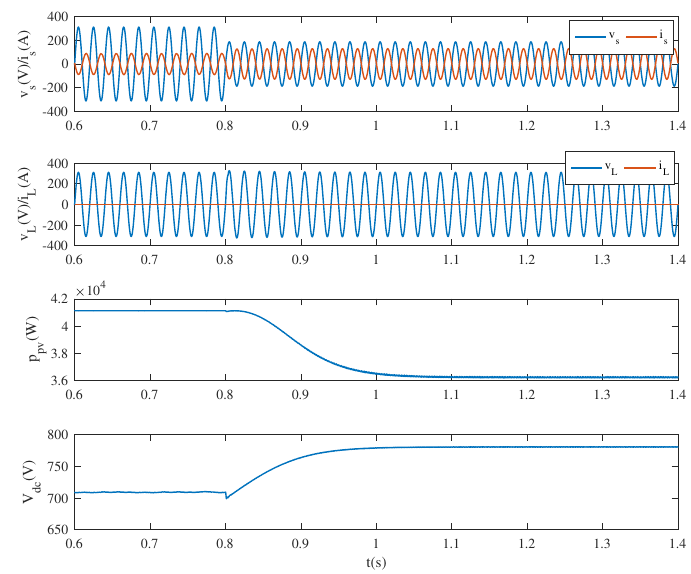
Figure 16. Simulation results under voltage sag of 0.4 p.u.